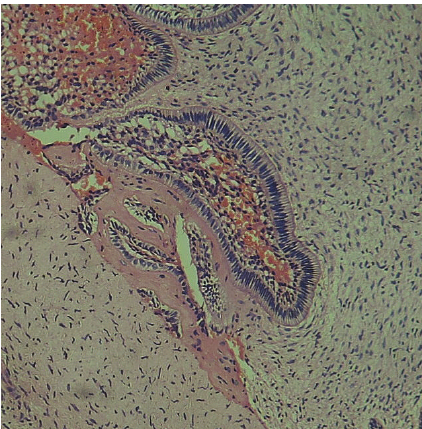
Figure 5: This figure shows an enamel organ type of odontogenic epithelium in association with an odontogenic ectomesenchyme. The hyalinised area containing entrapped cells is considered as dentinoid tissue due to its proximity to the odontogenic